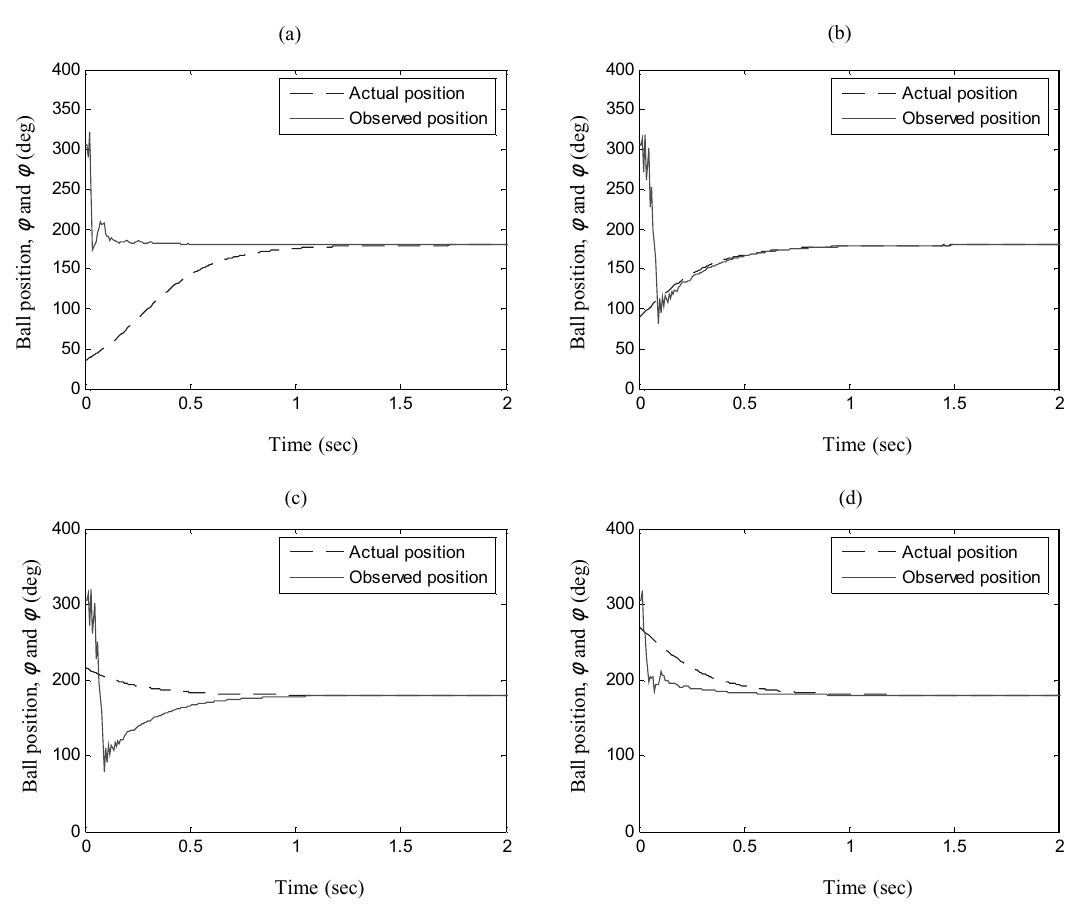
Fig. 11. Observed ball position based on the designed sliding-mode ball observer with l x = 460, k x = 4, a 1 = 1, a 2 = 4 and initial ball position at (a) 36 ◦ , (b) 90 ◦ , (c) 216 ◦ and (d) 270 ◦ . and Y motions of the spindle-disc-ABS system. It is seen from Fig. 14(a) that the ball final positions in notations of stars are indistinguishable from 180 degree as viewed from the photo in Fig. 14(a), and also the positions observed by the sliding-mode ball observer are very close to 180 degree. Note that the experimental ball position can only be obtained at steady state since at transient period the position of the fast-rolling ball leaves a long blurry arc along its trace in the photos taken by the camera. It should also be noted at this point that due to the very small deviation of ball position from the exact 180 deg in practice, there still exist minor residual vibrations of the spindle-disc-ABS system along X and Y directions, which is evidenced from small steady-state oscillations at steady state in Fig. 14(b–i). Also seen from Fig. 14(b,f) are larger levels of vibration at the transient period before the ball settling to the 180 deg, which in some way validate the capability of the ABS to reduce the radial vibrations with the ball positioned around 180 deg at the steady state. As to verificationof observerperformance, it is seen from the aforementionedsteady-state oscillations in Fig. 14(c,e,g,i) that the observed X and Y motions of the system closely follow the experimental counterparts, showing the effectiveness of the designed sliding-mode observer not only for ball position but